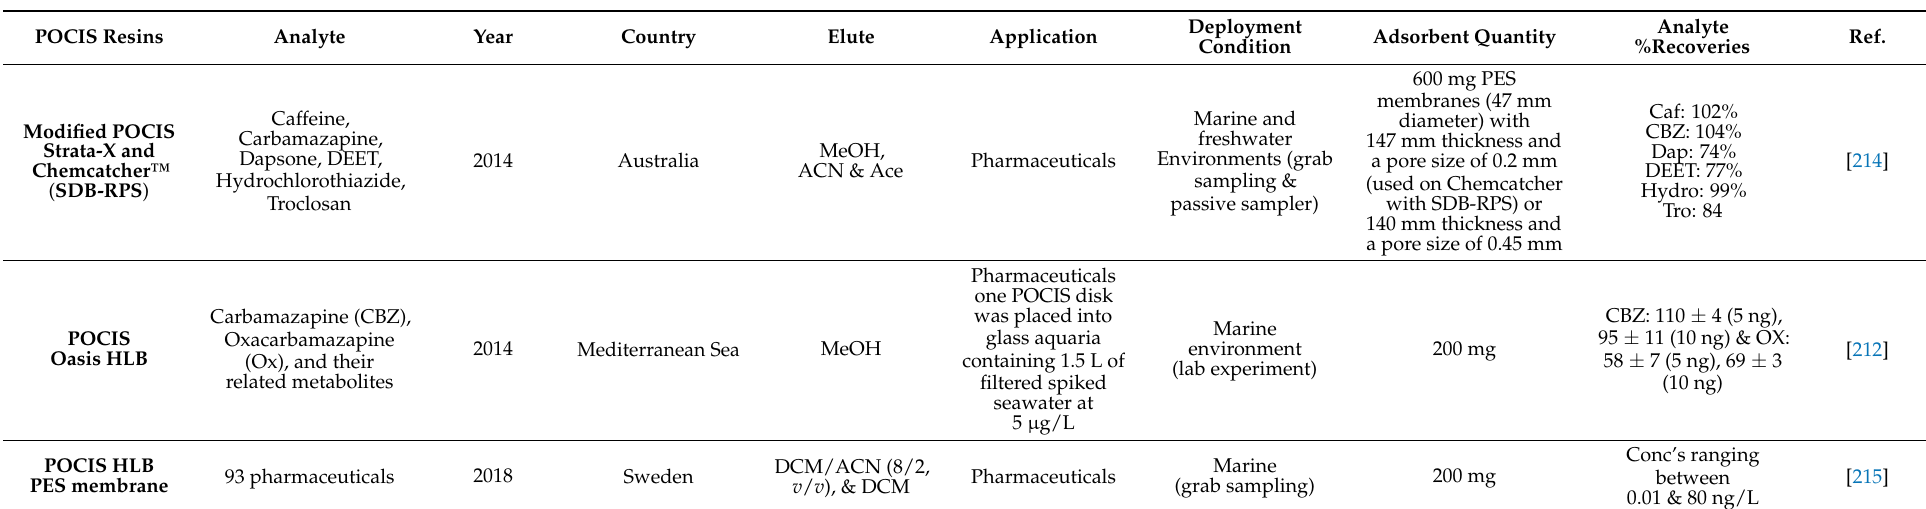
Table 6. The application of POCIS in the marine